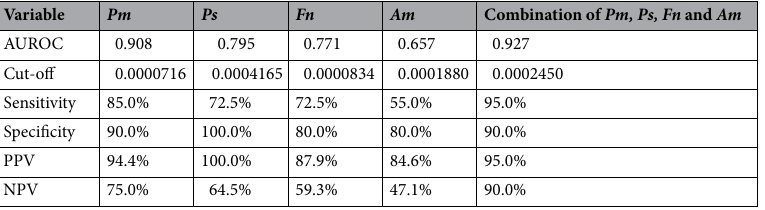
Table 6. Performance of Pm, Ps, Fn and Am as CRC biomarkers (validation cohort). NPV negative predictive value, PPV positive predictive value.